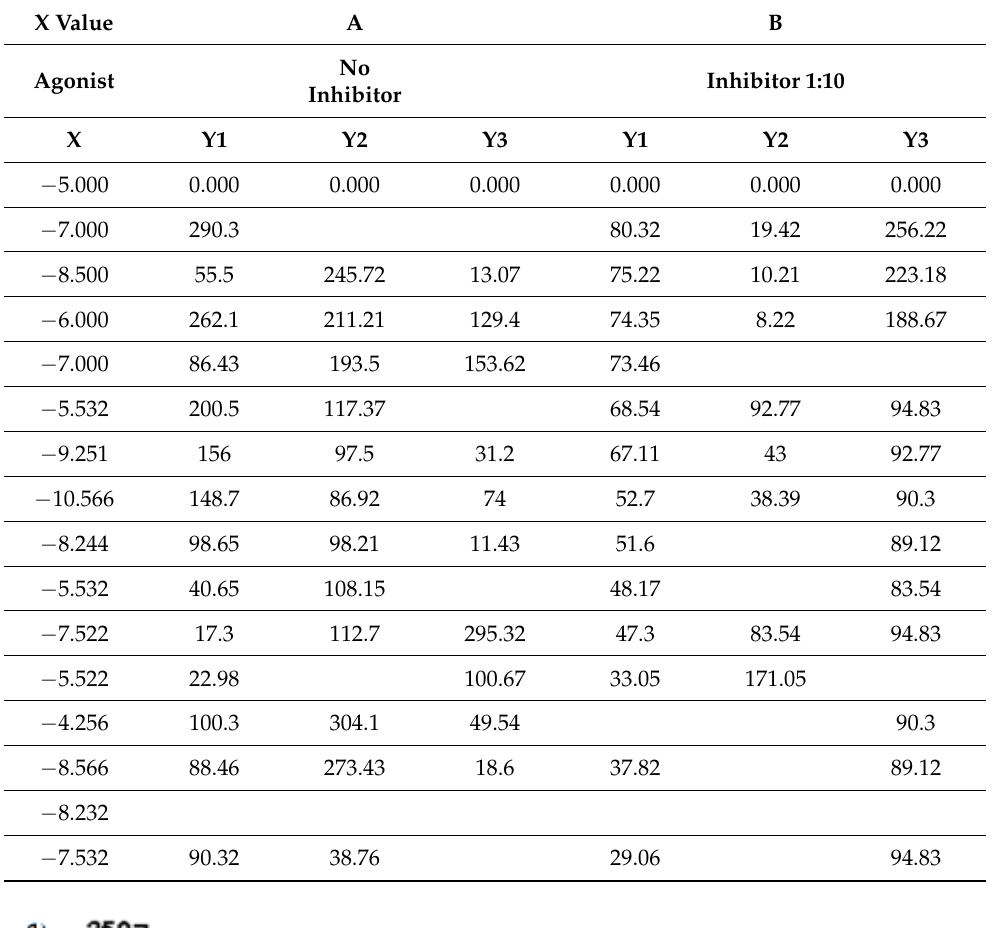
from Y1 to Y3 (replicates).